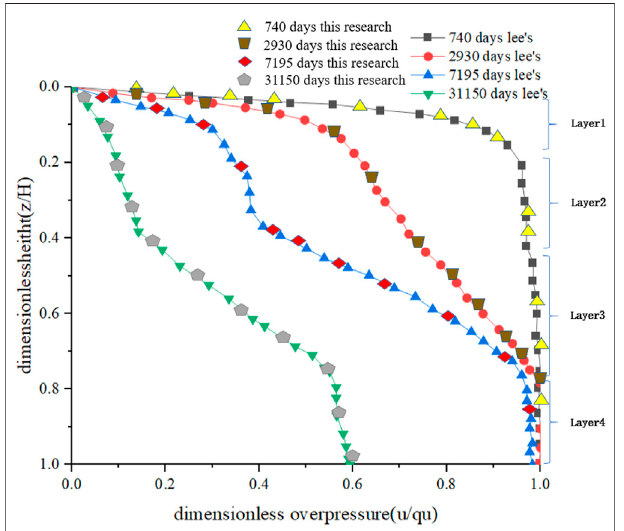
FIGURE 3 | Veri fi cation with Lee — excess pore water pressure isochrones and PTIB ( q u is the surcharge on the surface and H is the height of the multilayer system).